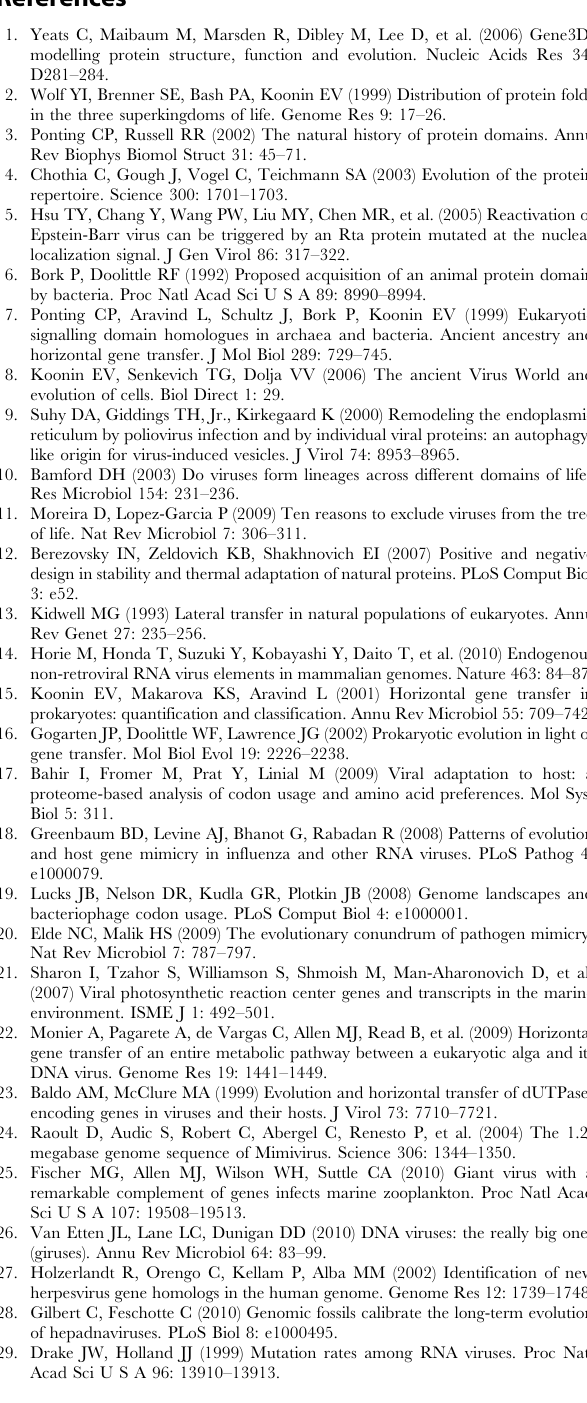
Table S1 Baltimore Classification for the major viral families infecting vertebrate. Table S2 Collection and properties of the UniRef90 clusters for virus-eukaryote cross-taxa. Table S3 Collection and properties of the 667 Pfam families of the cross-taxa of metazoa and